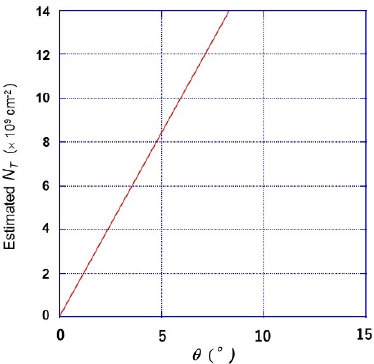
Figure 15. Dislocation distance D as a function of misfit angle θ in the boundary.